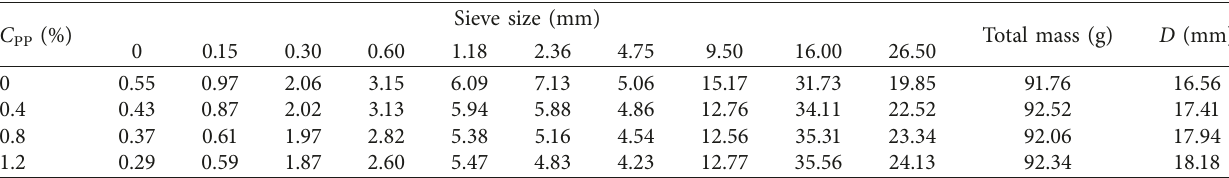
Table 5: The screening result and the average particle diameter D